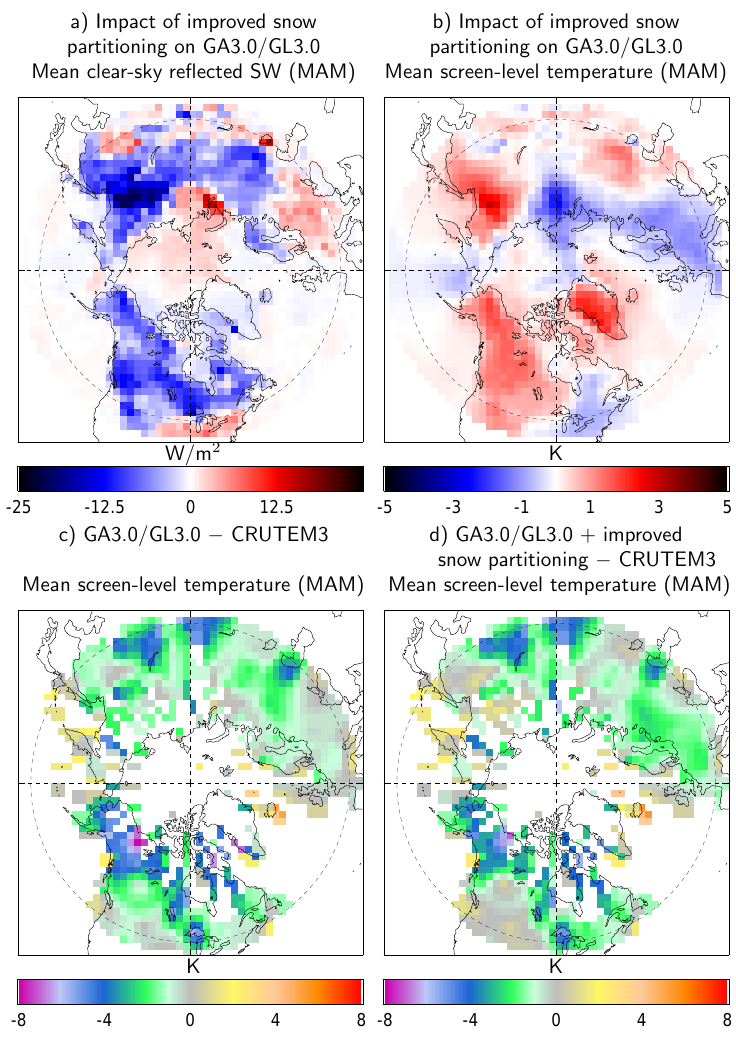
Fig. 5. Impact of the improved partitioning of snow on the mean clear-sky reflected SW radiation and screen-level temperature during MAM in a 10 yr N96 atmosphere/land-only climate simulation using the same format as Fig. 4.